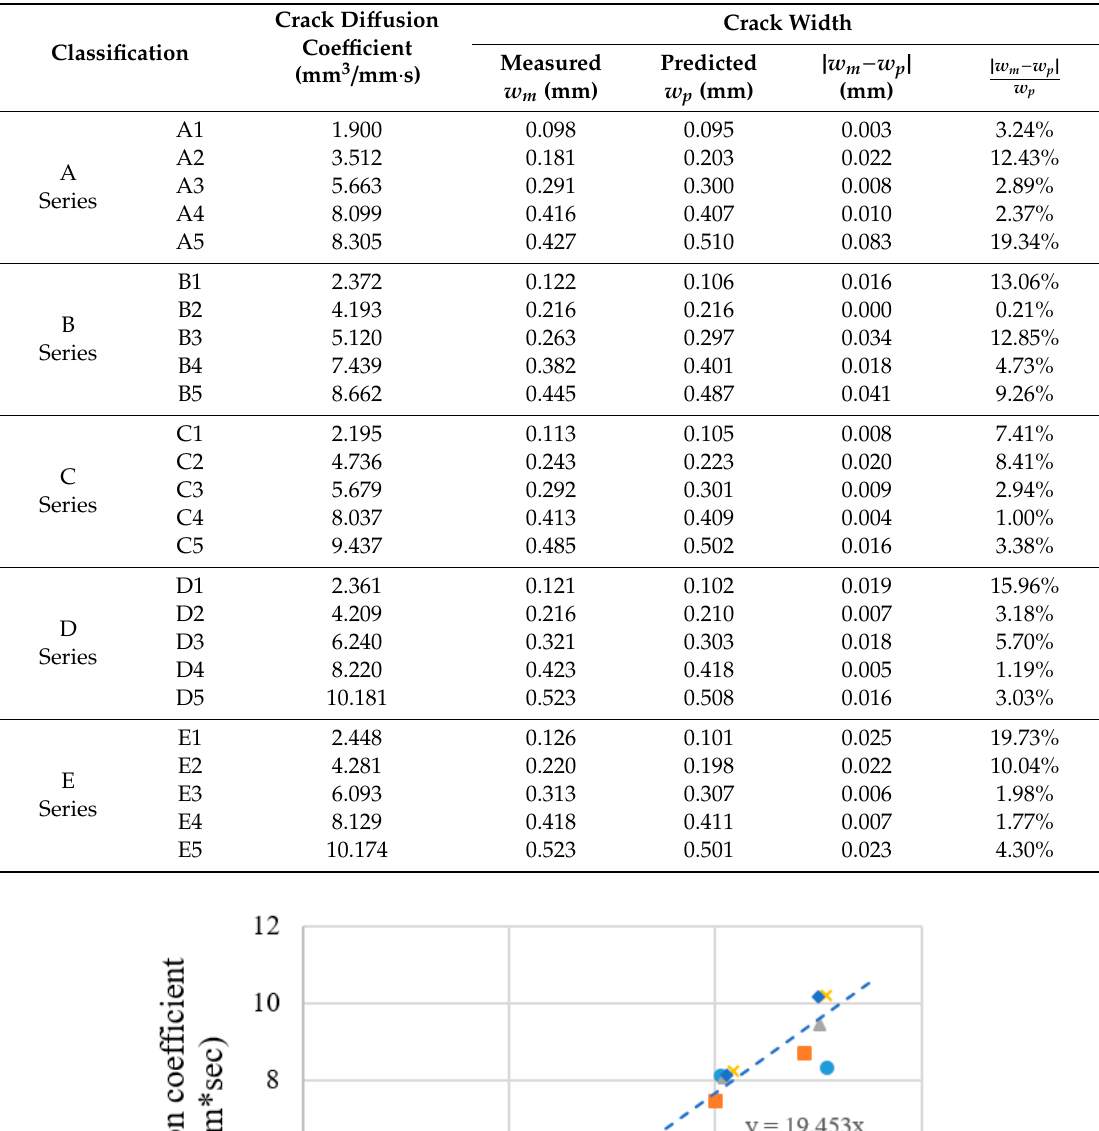
Table 3. Predicted crack width of acrylic specimens.